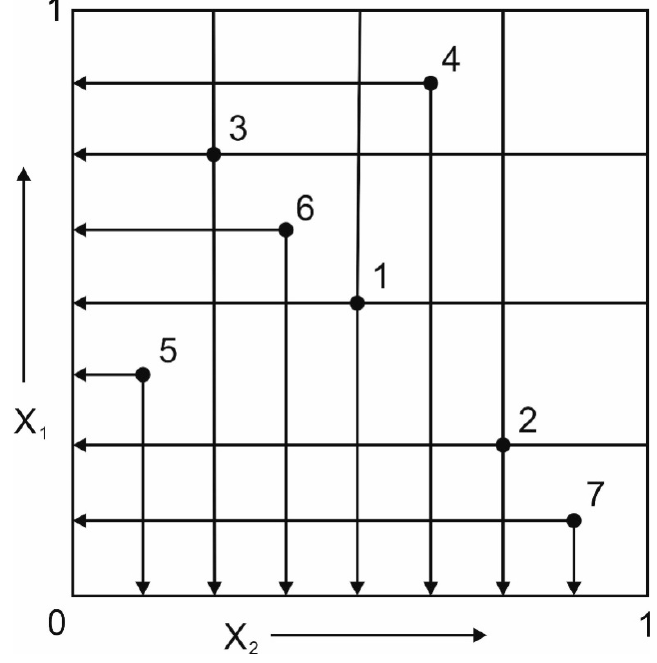
Figure 1. Location of research points on the X 1 and X 2 axes. Table 1. Point coordinates.